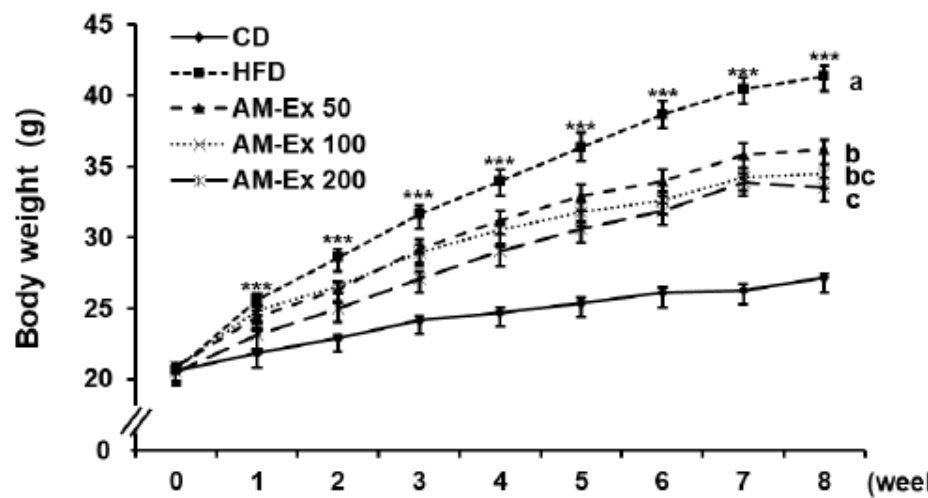
Figure 1. E ff ect of Aronia melanocarpa extract (AM-Ex) administration on body weight in high fat diet (HFD)-fed C57BL / 6N mice. AM-Ex was administered by oral gavage for eight weeks to mice fed the HFD. Body weights were measured every week. Each body weight point represents the mean ± standard error of the mean (SEM) (n = 10). *** P < 0.001 significantly di ff erent from the control diet (CD) group. Means without a common letter di ff er between HFD, AM-Ex 50, AM-Ex-100, and AM-Ex 200 groups at P < 0.05. Table 2. Effect of AM-Ex on body weight gain, fat mass percentage, food intake, and food efficiency ratio in HFD-fed C57BL/6N mice.